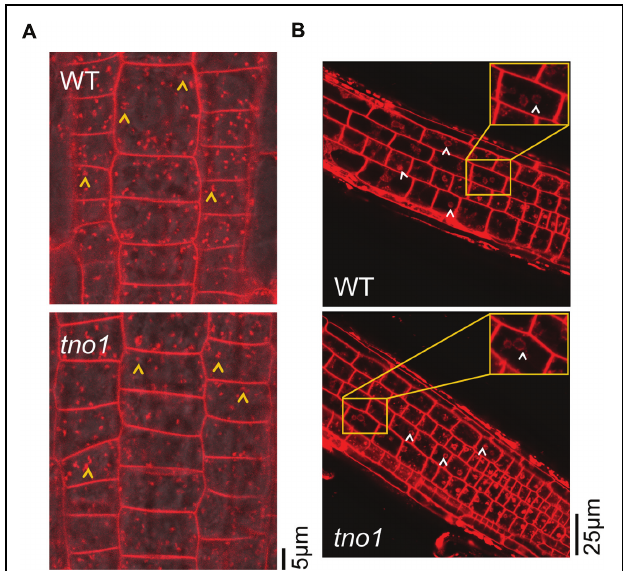
FIGURE 6 | tno1 mutants have normal bulk endocytosis and arrival of membrane cargo from plasma membrane to Brefeldin A (BFA) bodies. (A) Root cells showing uptake of FM4-64 after 2 min of treatment of 4-day-old seedlings with 4 µ M FM4-64 in liquid 0.5 × MS medium. Yellow arrowheads indicate early endosomes/TGN. (B) Root cells treated with 35 µ M BFA for 1 h, followed by a 10 min incubation with 4 µ M FM4-64, showing arrival of FM4-64 at BFA bodies. White arrowheads indicate BFA